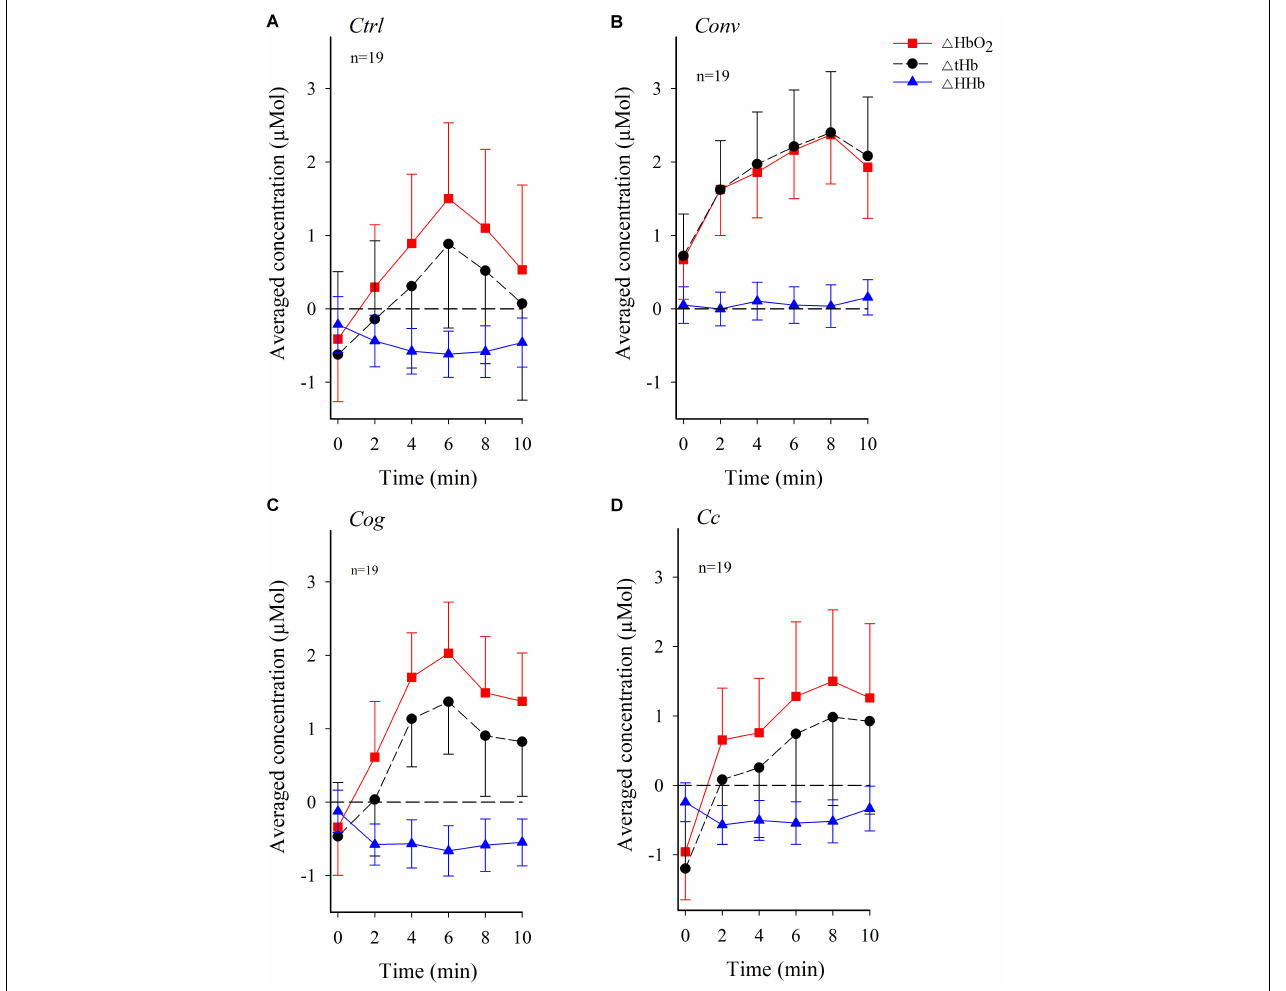
FIGURE 4 | Temporal pattern of changes in the concentration of oxygenated hemoglobin ( (cid:49) HbO 2 ) and deoxygenated hemoglobin ( (cid:49) HHb) along with variations in total hemoglobin ( (cid:49) tHb) in dlPFC across visual conditions (figure shows mean values, and standard errors). (A) Control condition Ctrl . (B) Convergence load condition Conv . (C) Cognitive control condition Cog . (D) Combined Convergence and Cognitive load, condition Cc . The stippled horizontal reference line denotes no change in baseline subtracted hemodynamic